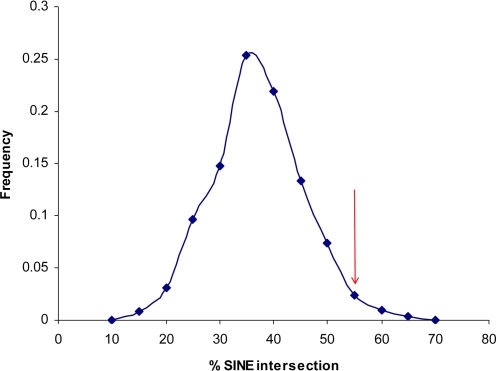
Frequency distribution of the percentage of SINE intersection as computed for 1000 sets of 40 random sequences, compared with the percentage determined for the 40 breakpoint flanking sequences (red arrow).